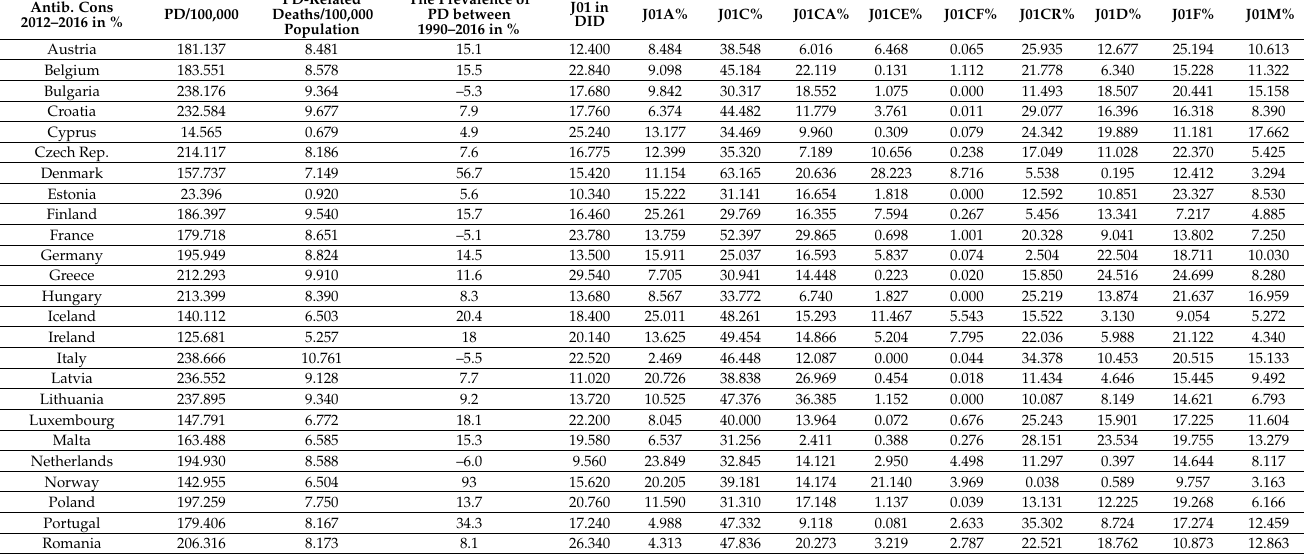
Table 4. Average antibiotic consumption for 2012–2016 expressed as a relative share in % of the total systemic antibiotic consumption in the community estimated in Defined Daily Dose/1000 Inhabitants/Day (DID) compared to the prevalence of PD estimated for 2016, the change of prevalence between 1990–2016 in percentage (%), and the PD-related deaths/100,000 population. Positive, significant correlation or significantly elevated risk was estimated, when the p -value showed ≤ 0.05 ( p = ≤ 0.05) (marked with yellow filling color) and the negative correlation or lowered risk was marked with green filling color. Positive/negative, non-significant correlations or elevated/lowered risks were considered when the p -value fell between 0.051 and 0.09 ( p = 0.051 ≤ 0.09) and marked with an orange filling